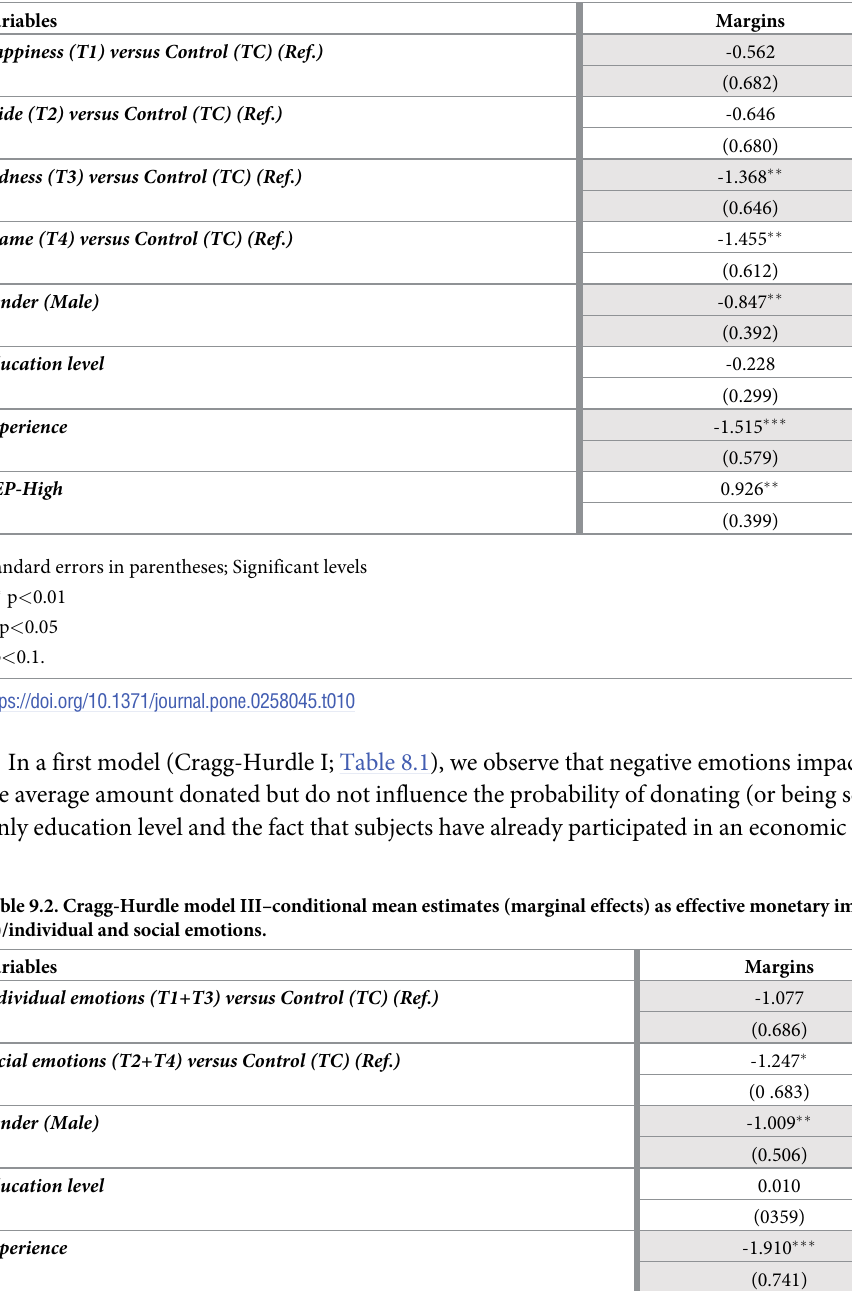
Experience NEP-High